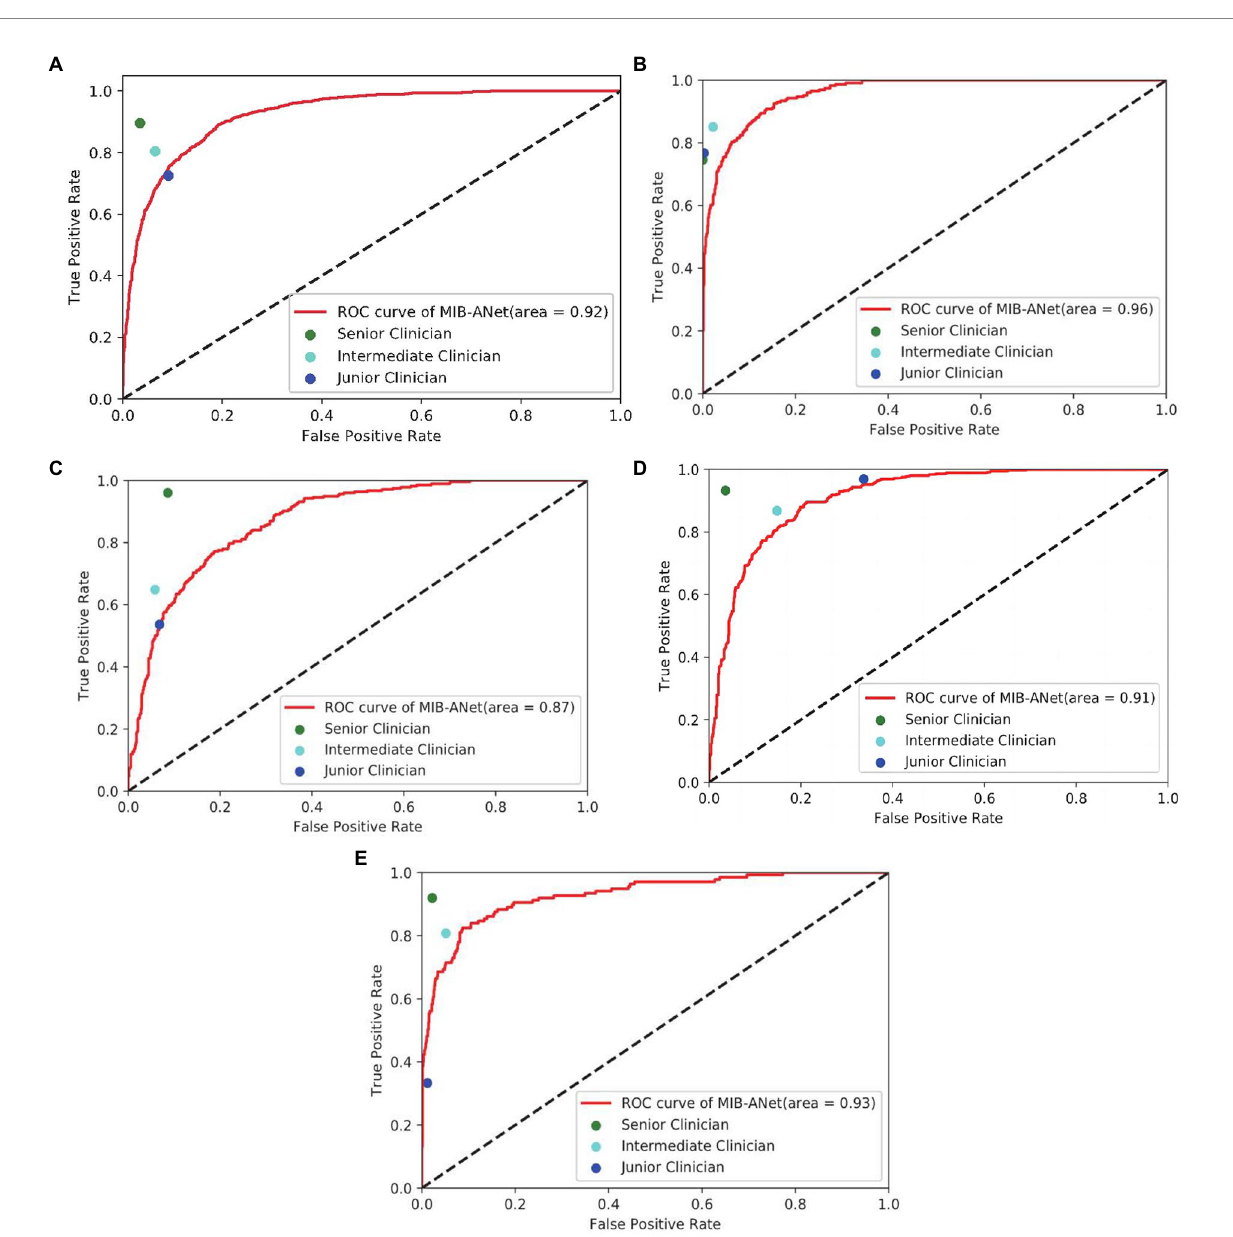
FIGURE 3 (A–E) show the overall micro-average ROC curve of MIB-ANet and that for grade 1 to 4 adenoid hypertrophy respectively, compared with TPR and FPR of 3 E.N.T.